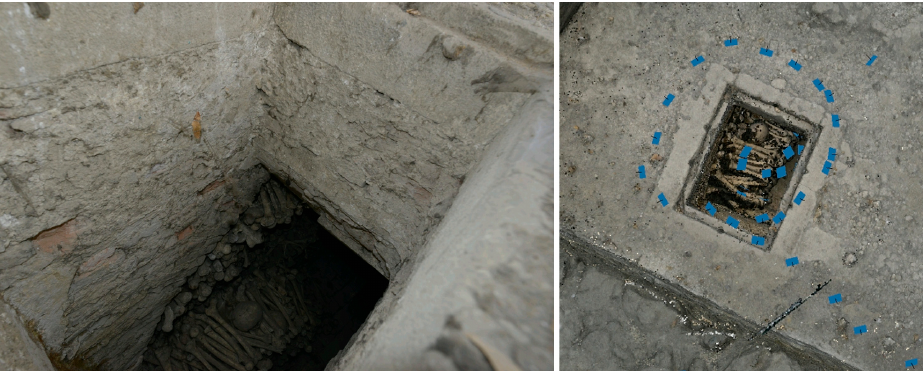
Figure 5. Opening no. 2 ( left ), and the positions of the cameras in the connecting image strip ( right ).